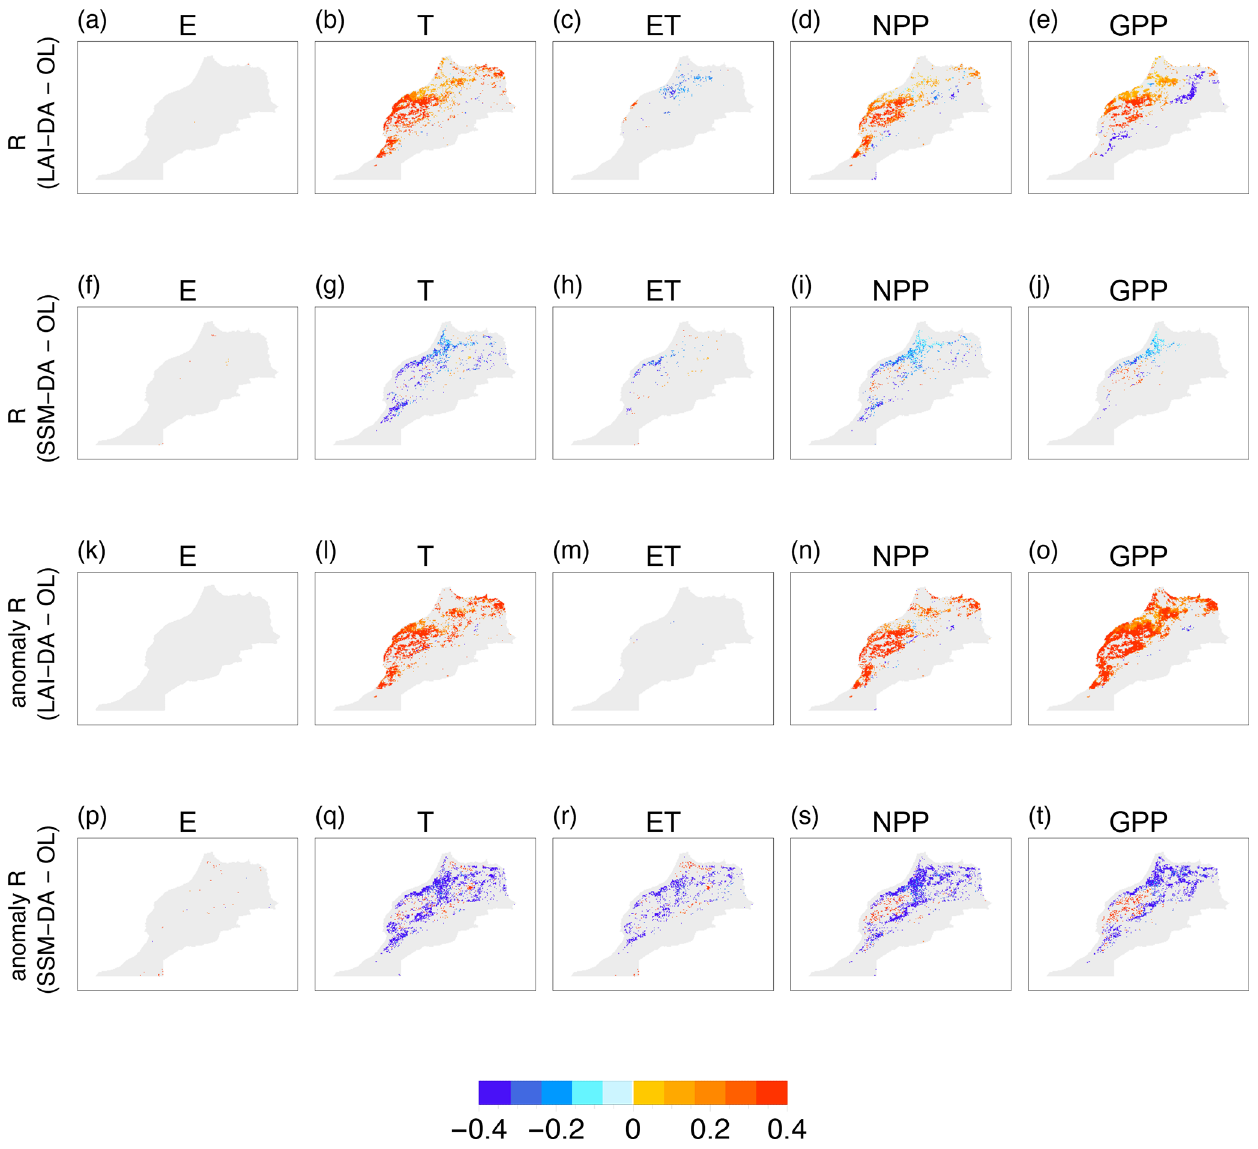
Figure 2. The difference in correlation ( R ), computed as DA minus OL for the period of 2015–2019, for (a–e) LAI-DA and (f–j) SSM- DA simulations in terms of evaporation ( E ), transpiration ( T ), evapotranspiration (ET), net primary production (NPP), and gross primary production (GPP). Panels (k) – (t) are the same but for the difference in anomaly correlation (anomaly R ). Red colors indicate that the assimilation improves R or anomaly R , with respect to the OL, and blue colors indicate a degradation at 95% significance level using Fisher’s z transform